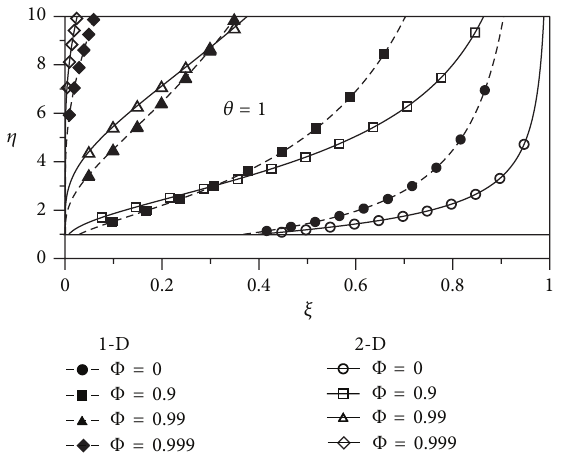
Figure 6: Optimum profiles of metal content at 𝜃 = 1 , 𝑔(𝜂) = 𝜂 .